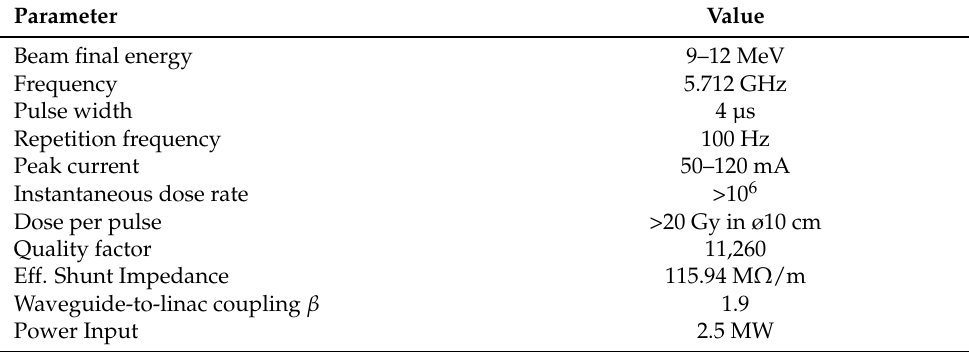
Table 1. C-band linac parameters for IOeRT FLASH